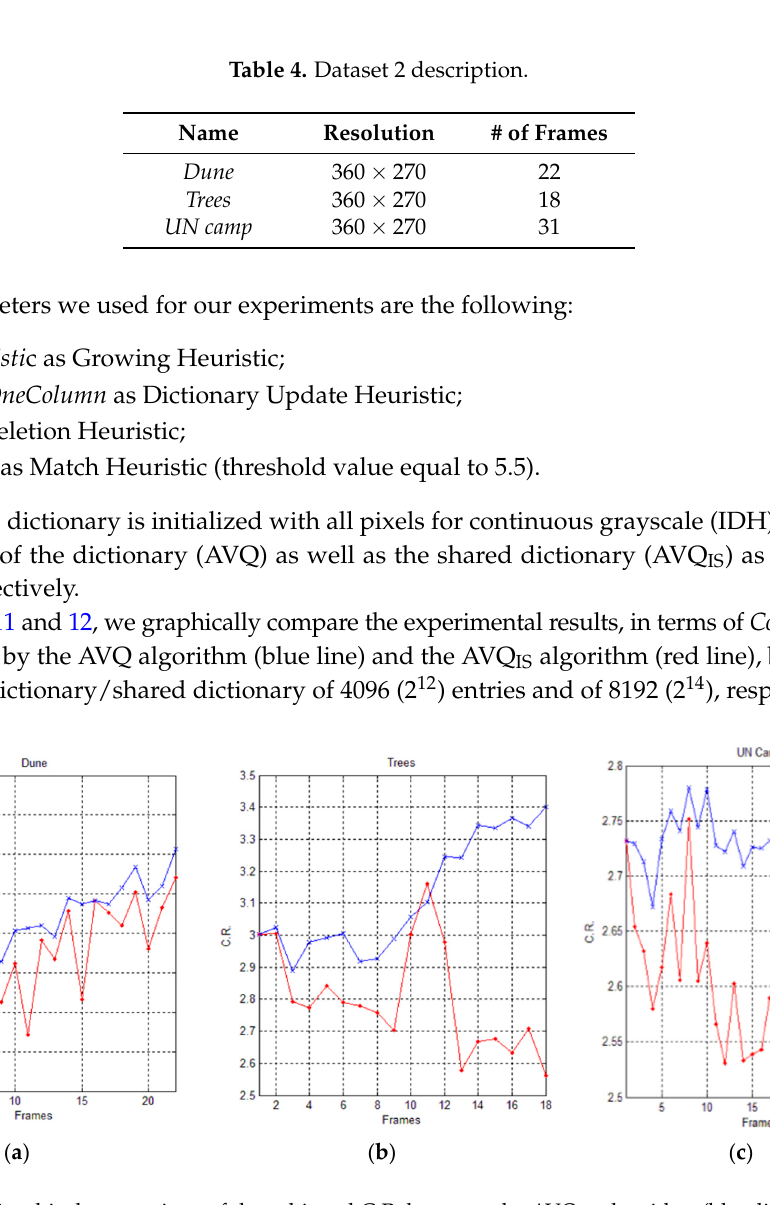
Figure 11. Graphical comparison of the achieved C.R. between the AVQ IS algorithm (blue line) and the AVQ algorithm (red line), by using a dictionary of 4096 (2 12 ), for ( a ) the Dune sequence; ( b ) the Trees sequence; and ( c ) the UN camp sequence.